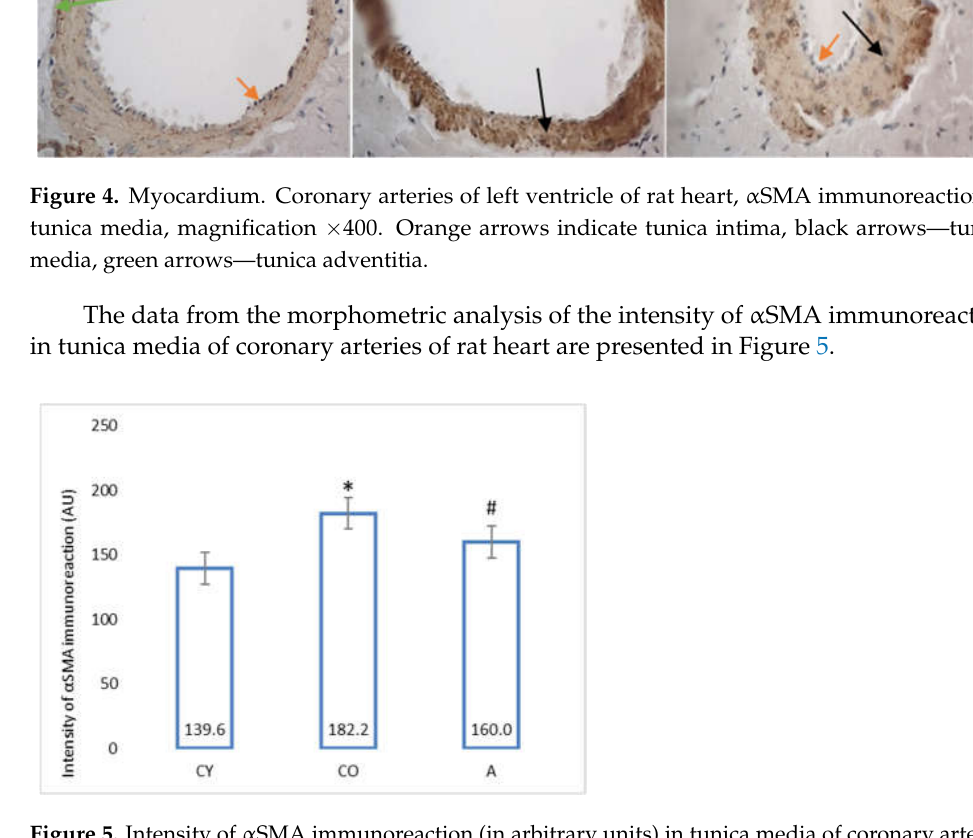
Figure 5. Intensity of αSMA immunoreaction (in arbitrary units) in tunica media of coronary arteries of rat heart. * CO vs. CY, p < 0.05, # A vs. CO, p < 0.05 .